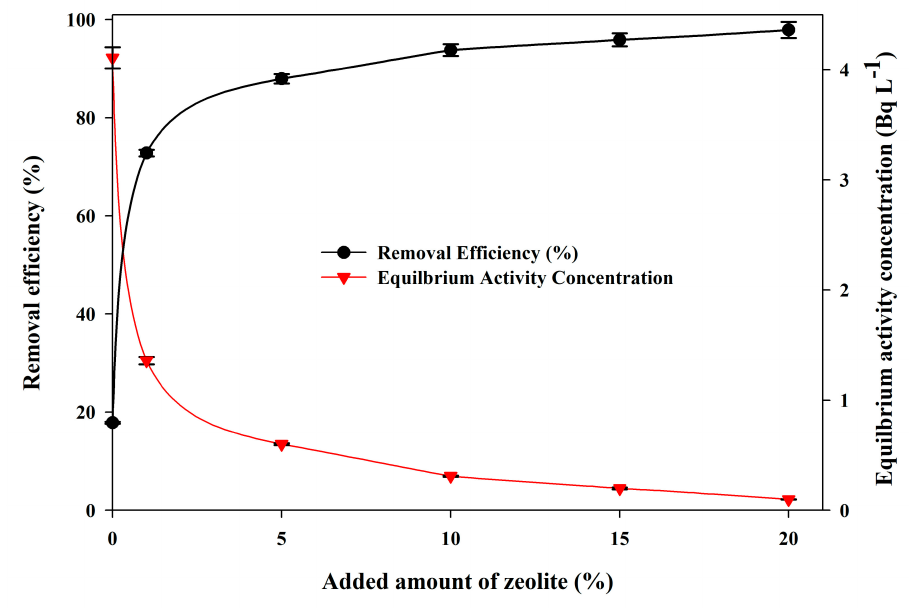
Figure 5. The adsorption e ffi ciency of 226 Ra by sandy soil amended with